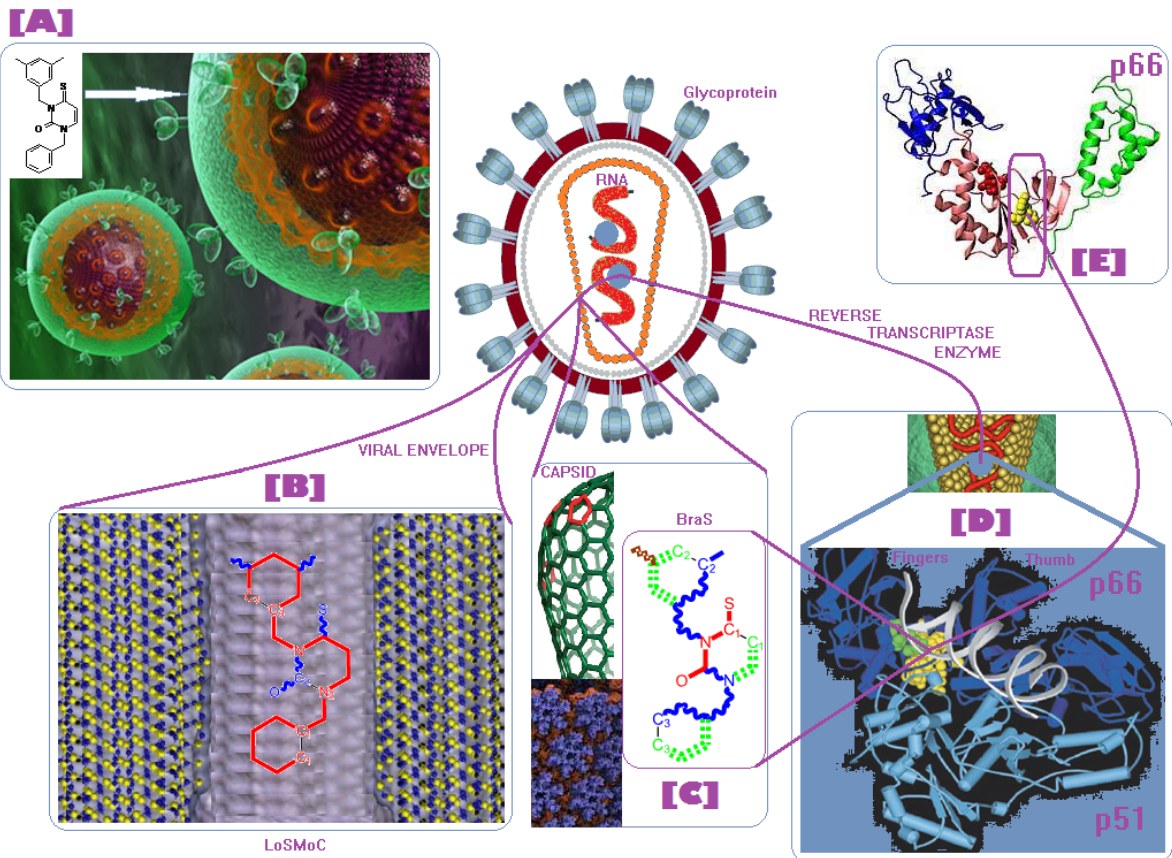
Figure 3. The mechanism of molecular interaction of the 1,3-disubstituted uracils, with prototype no. 31 of Table 1 (since belonging to all selected QSAR-SMILES criteria and cases of Table 3) against human immunodeficiency virus (HIV-1), after Ref. [143], through five stages: ( A ) the free molecular attack on the HIV viral envelope, after Ref. [144]; ( B ) the passage of the lipidic viral envelope of HIV under the form of longest SMILES molecular chain (LoSMoC) of Table 1, after Refs. [64,145,146]; ( C ) the transport though the protein layer of HIV capsid, after Refs. [147,148], yielding the Branching SMILES (BraS) configuration of Table 1 that further binds in ( D ) with the palm active region of p66 monomer of reverse transcriptase (RT), after Refs. [149,150], towards ( E ) the competitively inhibiting the RT by the formed ligand-receptor complex, after Ref. [151], by means of chemical reactivity frontier electronic transfer as detailed in the Figure